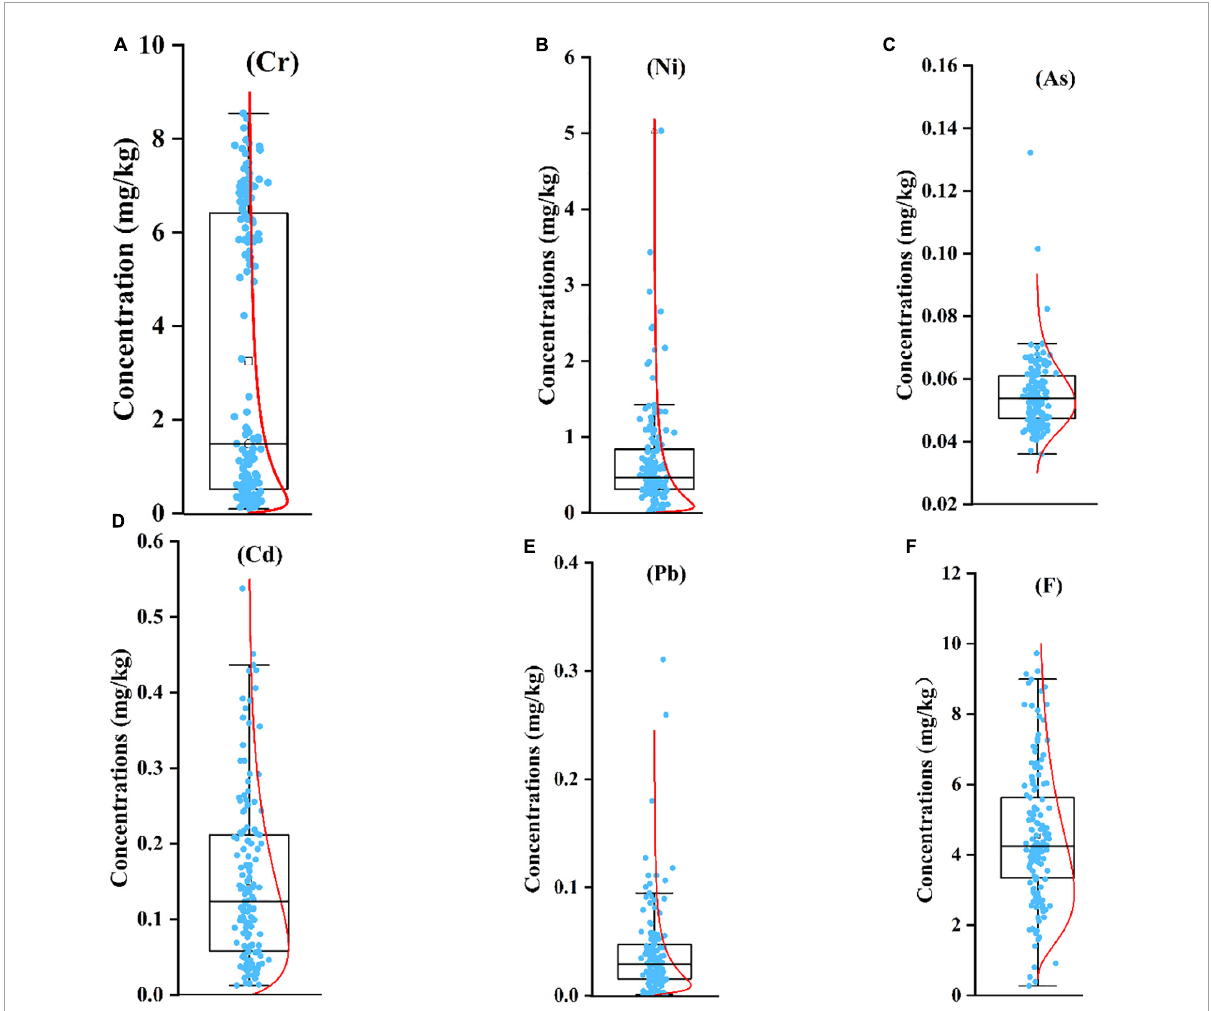
FIGURE2 The PTE concentration (mg/kg) in wheat grain samples collected from Bijie, Guizhou Province [ (A) Cr, (B) Ni, (C) As, (D) Cd, (E) Pb, (F) F]. The red line indicates “normal curve.”